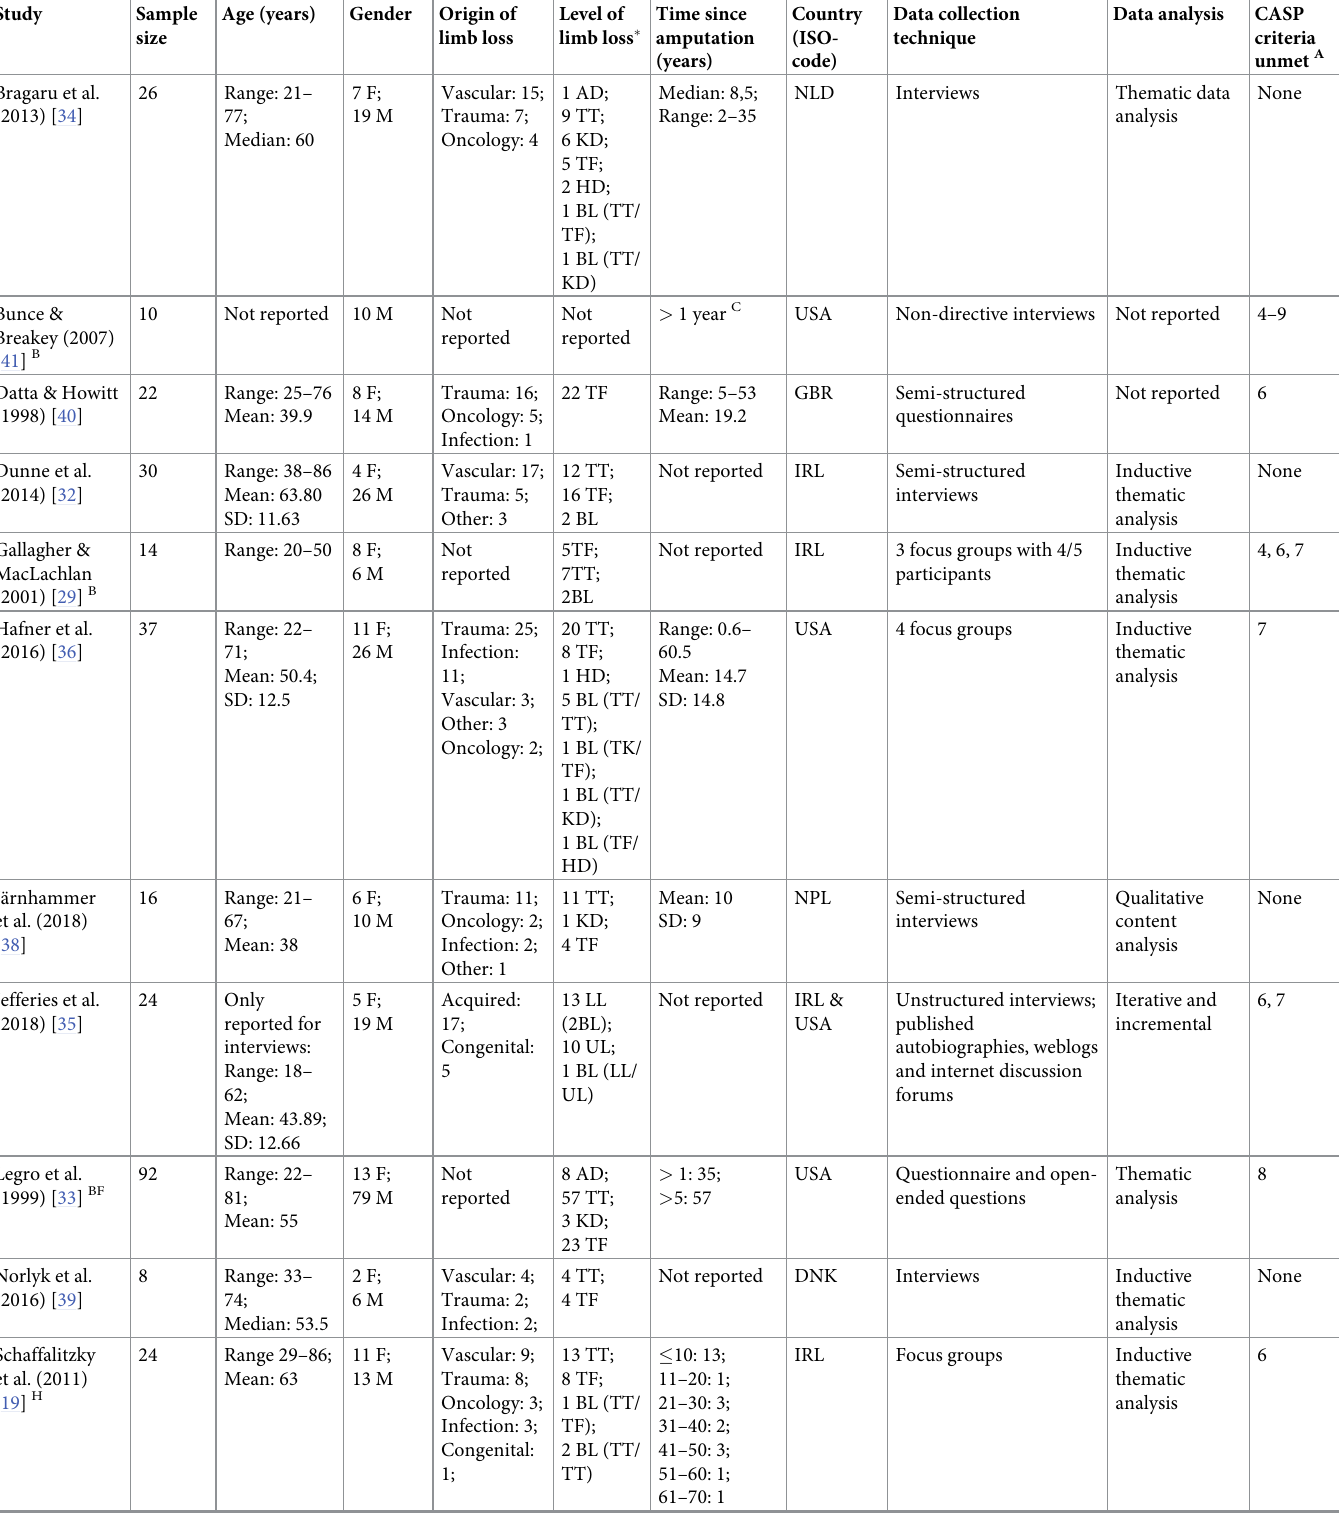
Table 2. Summary of sample characteristics, used methodologies and quality assessment from included